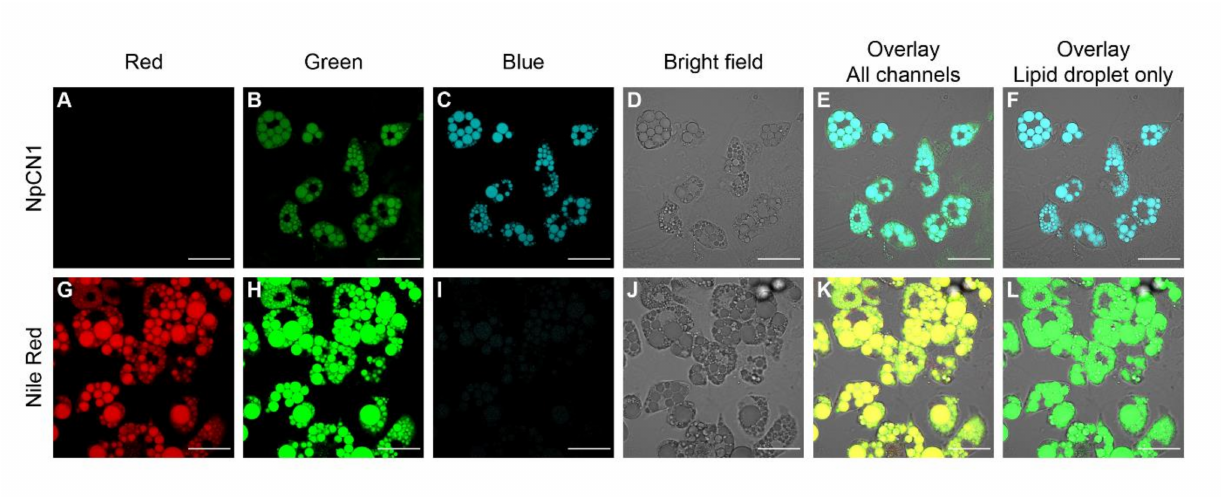
Figure 3. Confocal microscopy images of live 3T3-L1 adipocytes treated with ( A – F ) NpCN1 (20 µ M, 4 h) or ( G – L ) Nile Red (10 µ M, 4 h). Live cells were imaged in ( A , G ) red ( λ ex = 561 nm, λ e m = 570–670 nm), ( B , H ) green ( λ ex = 488 nm, λ e m = 500–600 nm) and ( C , I ) blue ( λ ex = 405 nm, λ em = 450–550 nm) channels, along with ( D , J ) bright field images. ( E , K ) shows the overlay of all channels; ( F ) shows the overlay of C and D, ( L ) shows the overlay of H and K. The scale bar on all images represents 50 µ